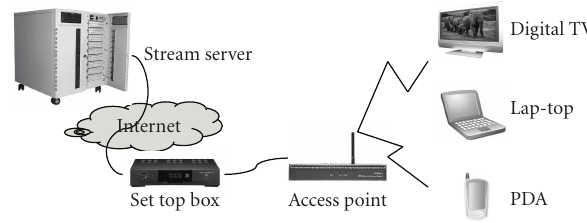
Figure 1: Stream service based on the STB and